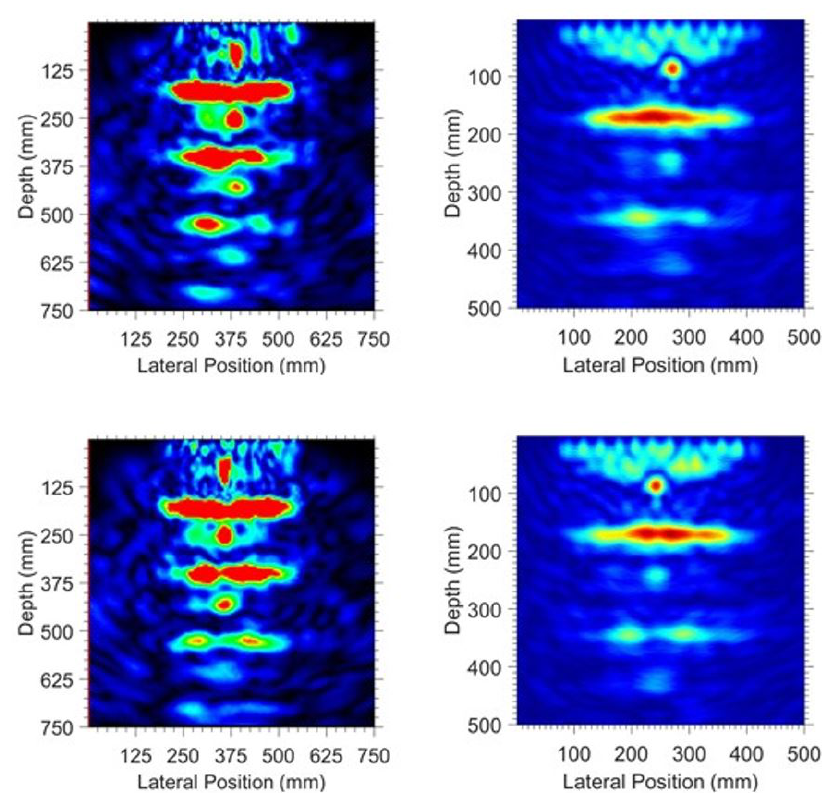
Figure 11. Standard (left) and evaluated (right) images of the other CS’ points over the 94 mm-deep